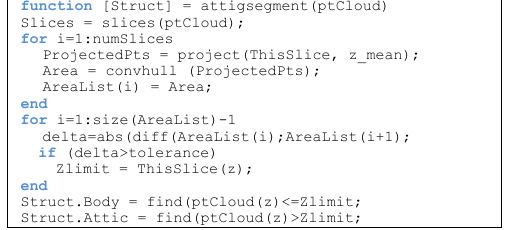
Figure 1. Pseudocode for the attic detection function.